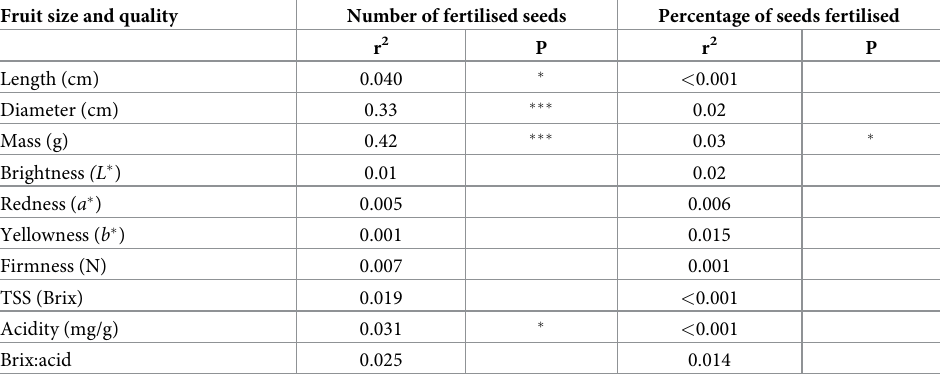
Significant linear regressions are indicated by